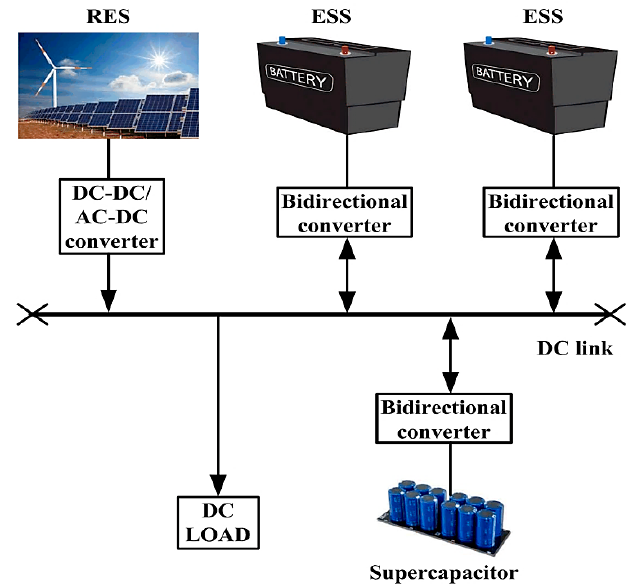
Figure 1. Typical DC microgrid (µG) system.